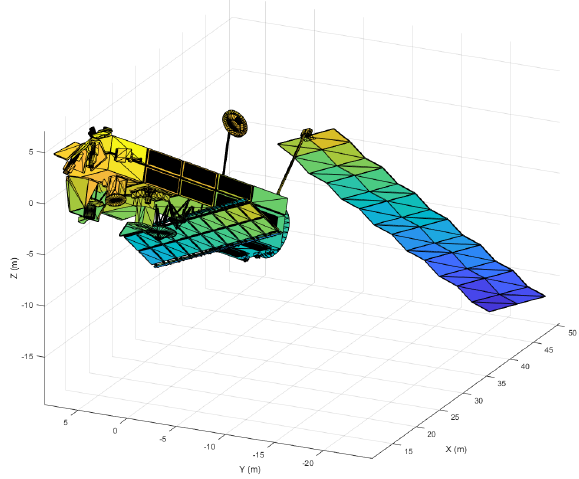
Figure 3. STL model of the Envisat